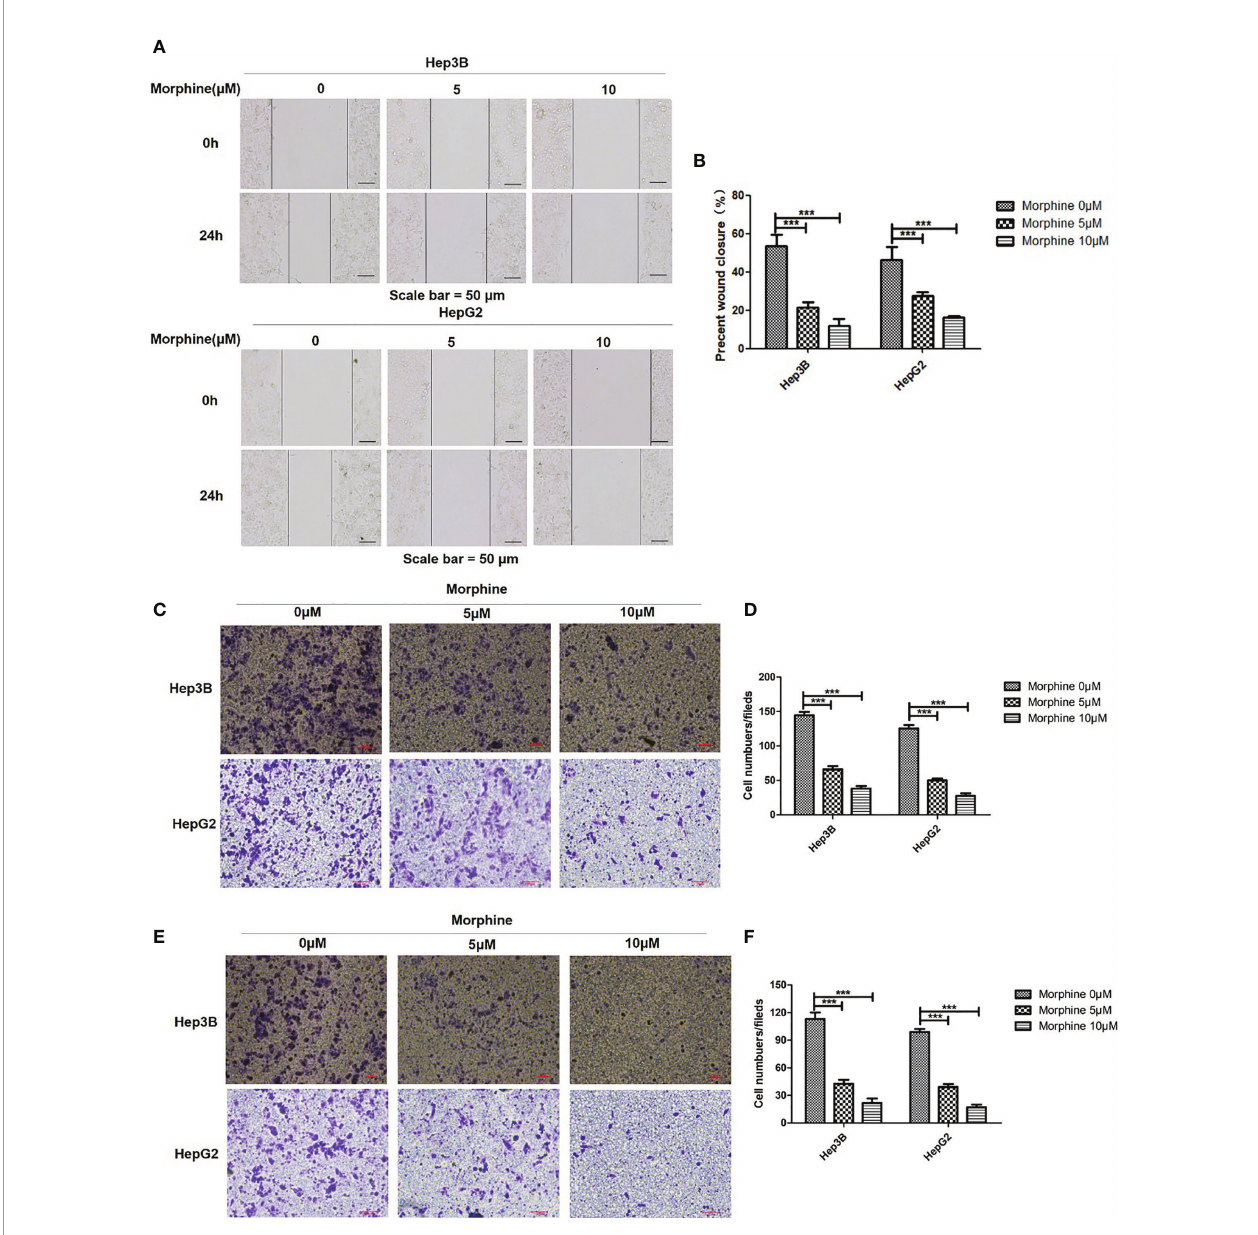
FIGURE 3 | Morphine suppresses the migration and invasion ability of Hep3B/HepG2 in vitro . (A) Representative image of wound healing assay and (B) quantitative analysis of wound healing assay of Hep3B/HepG2 exposed to morphine for 24h. (C) Representative image of transwell analysis of migration and (D) quantitative analysis of migration of Hep3B/HepG2 exposed to morphine for 24h. (E) Representative image of transwell analysis of invasion and (F) quantitative analysis of invasion of Hep3B/HepG2 exposed to morphine for 24h. Data are expressed as mean ± SE; n=3. *** P <